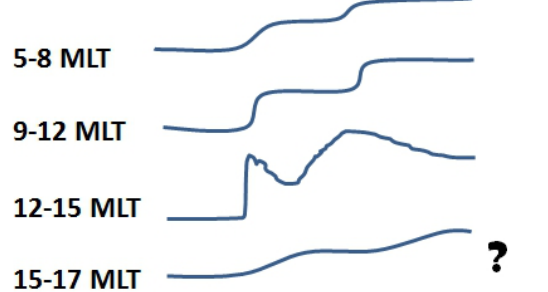
Figure 8. Sketch profiles of the total magnetic field observed in the Fig. 8. Sketch profiles of the total magnetic field observed on the geostationary orbit in four different sectors: 5–8, 8–12, 12–15, and geostationary orbit in 4 different sectors: 5-8 MLT, 8-12 MLT, 12- 15–17MLT. 15 MLT, and 15-17 MLT.